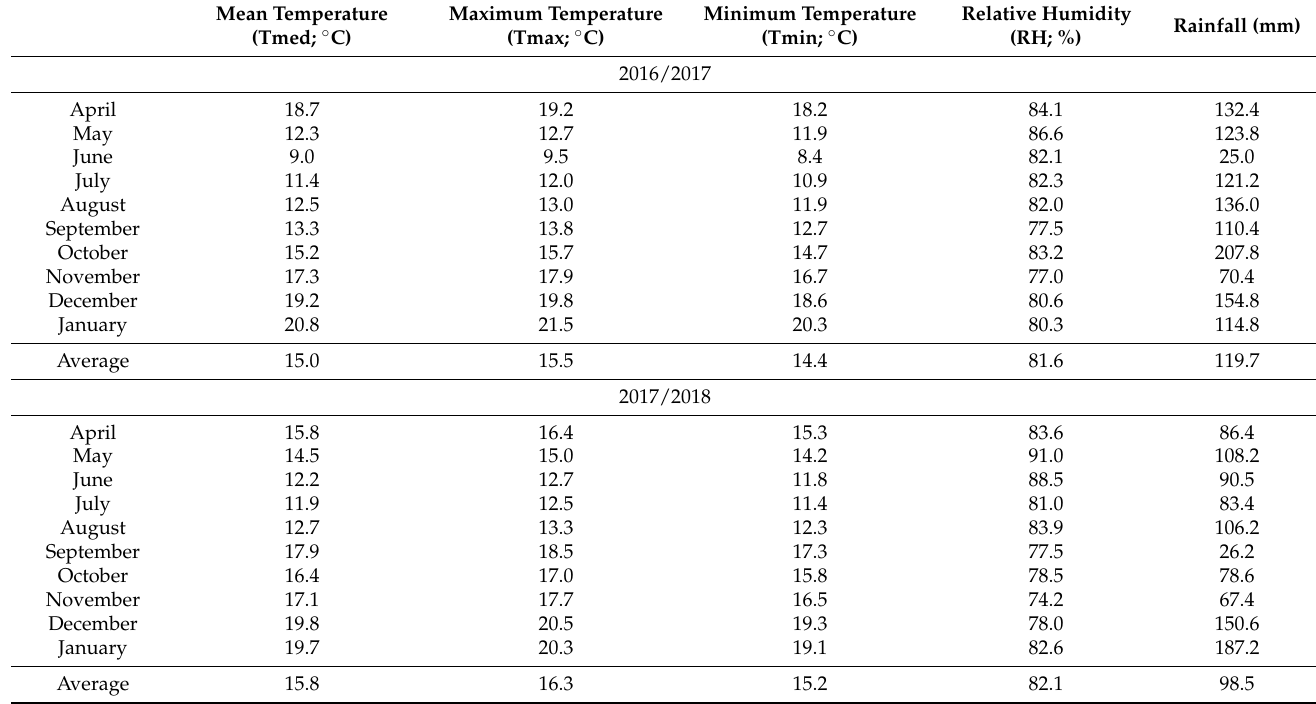
Table 1. Mean values of environmental variables measured in the 2016/2017 and 2017/2018 production cycles. Mean Temperature (Tmed; ◦